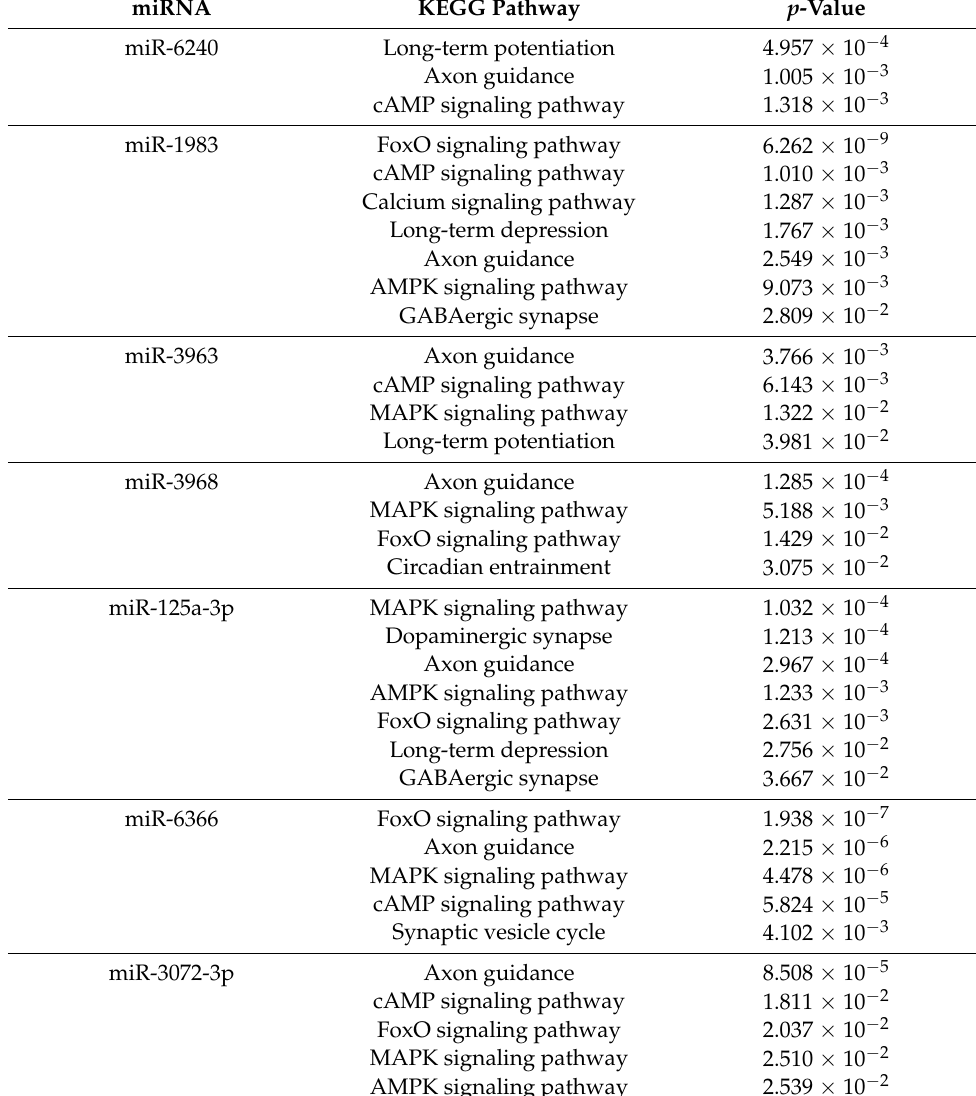
Table 2. KEGG pathway analysis of genes regulated by